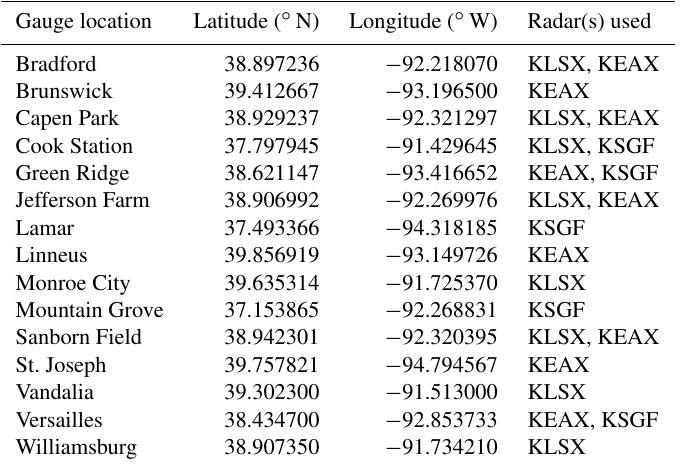
Table 1. Terrestrial-based precipitation gauge locations used for the study in addition to the National Weather Service radars from Springfield, MO (KSGF), Kansas City, MO (KEAX), and St. Louis, MO (KLSX), used in conjunction with each gauge.